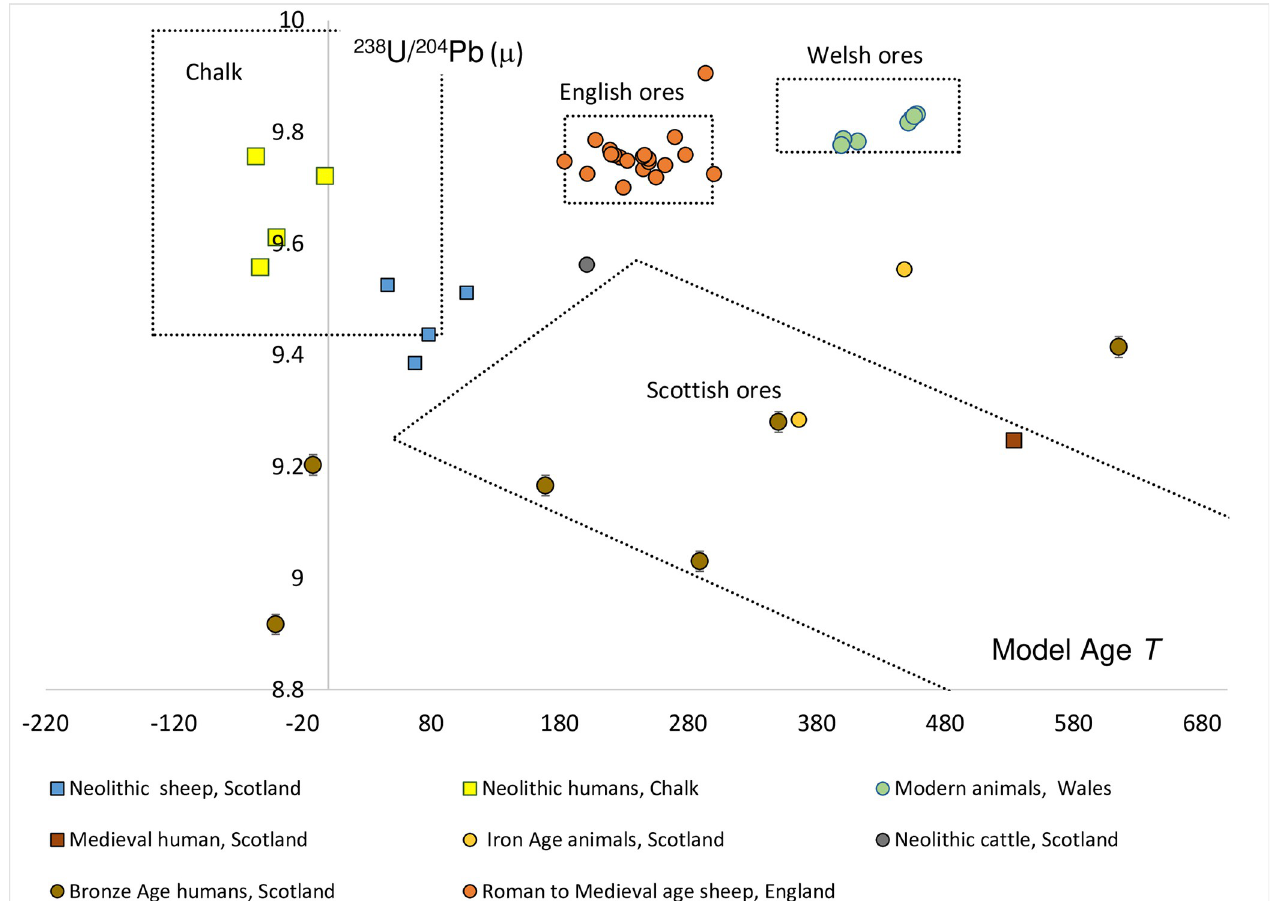
Fig 3. Validation of mineral data fields using published human and faunal sample data sources [11, 25, 43, 44] and data from this study.